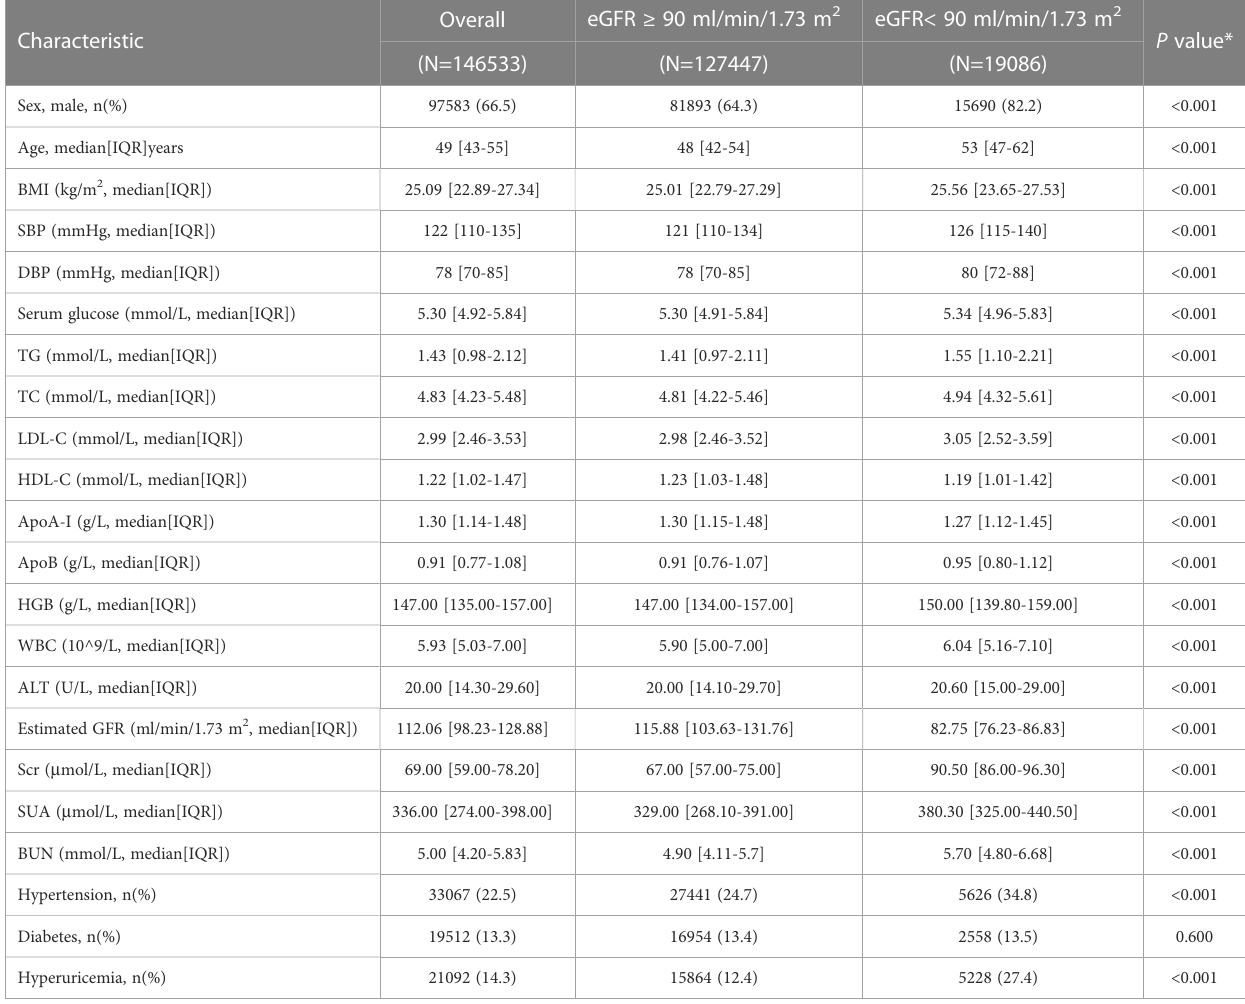
TABLE 1 Baseline characteristics of the cross-sectional population.